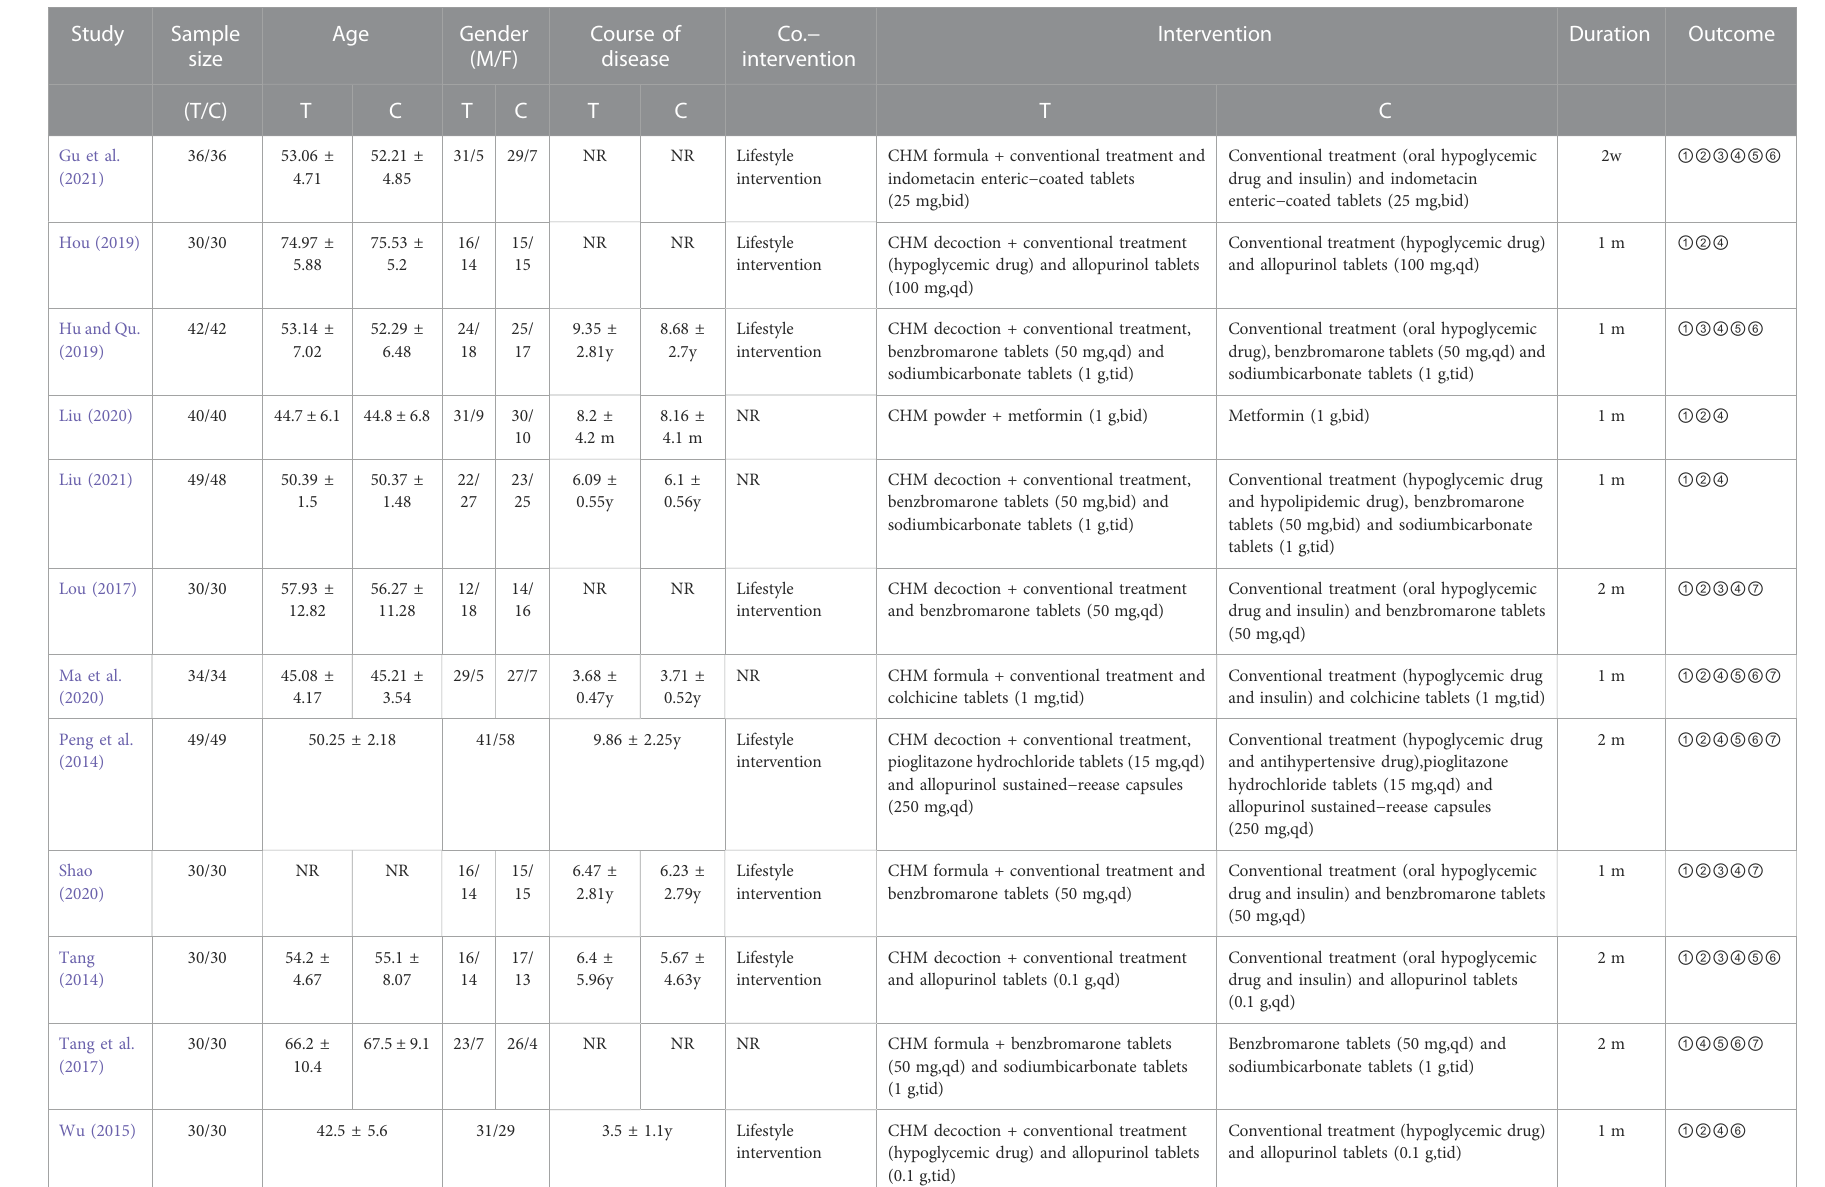
TABLE 1 Characteristics of the included